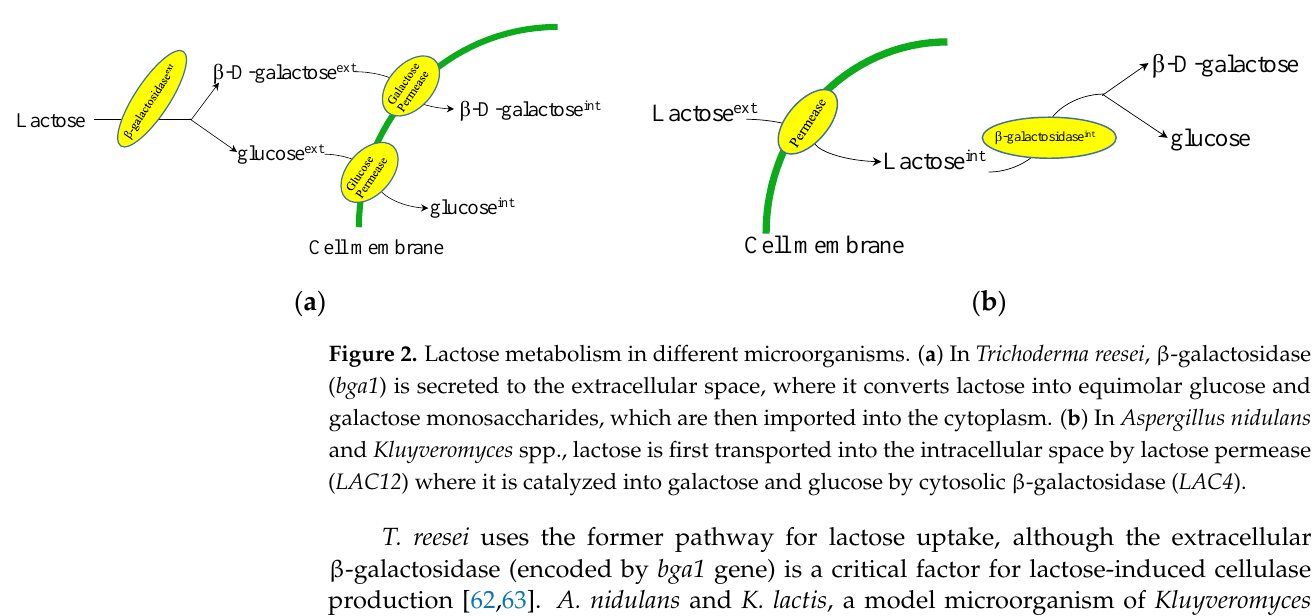
extracellularly hydrolyzed into D -glucose and D -galactose, which are subsequently taken up by the fungi (Figure 2a); and (2) the disaccharide is first imported into the cytosol and then hydrolyzed into glucose and galactose (Figure 2b).